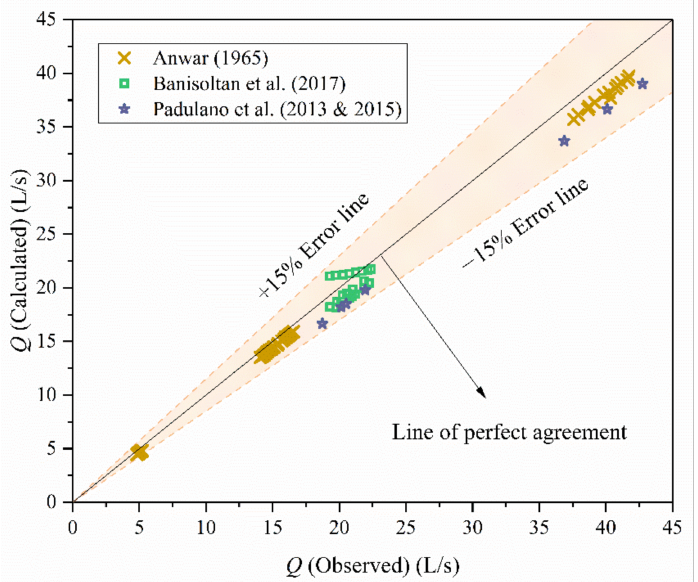
Figure 7. Comparison of the calculated discharge and the observed discharge.